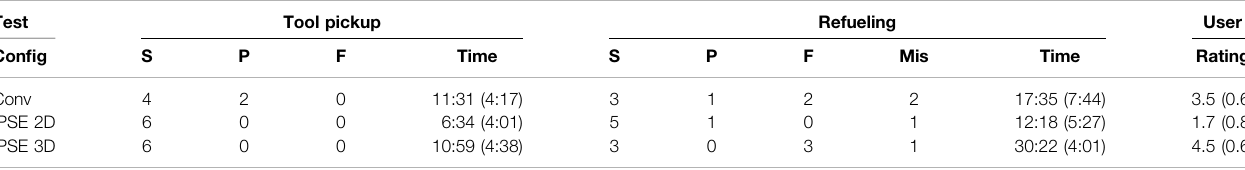
TABLE 3 | IPSE experimental results for tool pickup and refueling tasks, indicating number of trials (of 6 for each test con fi guration) with full success (S), partial success (P), and failure (F); number of successful trials with tool misalignment (Mis.) in refueling task; task times ( min:sec ) and user ratings (1-5, in order of increasing dif fi culty), in format mean (standard deviation)